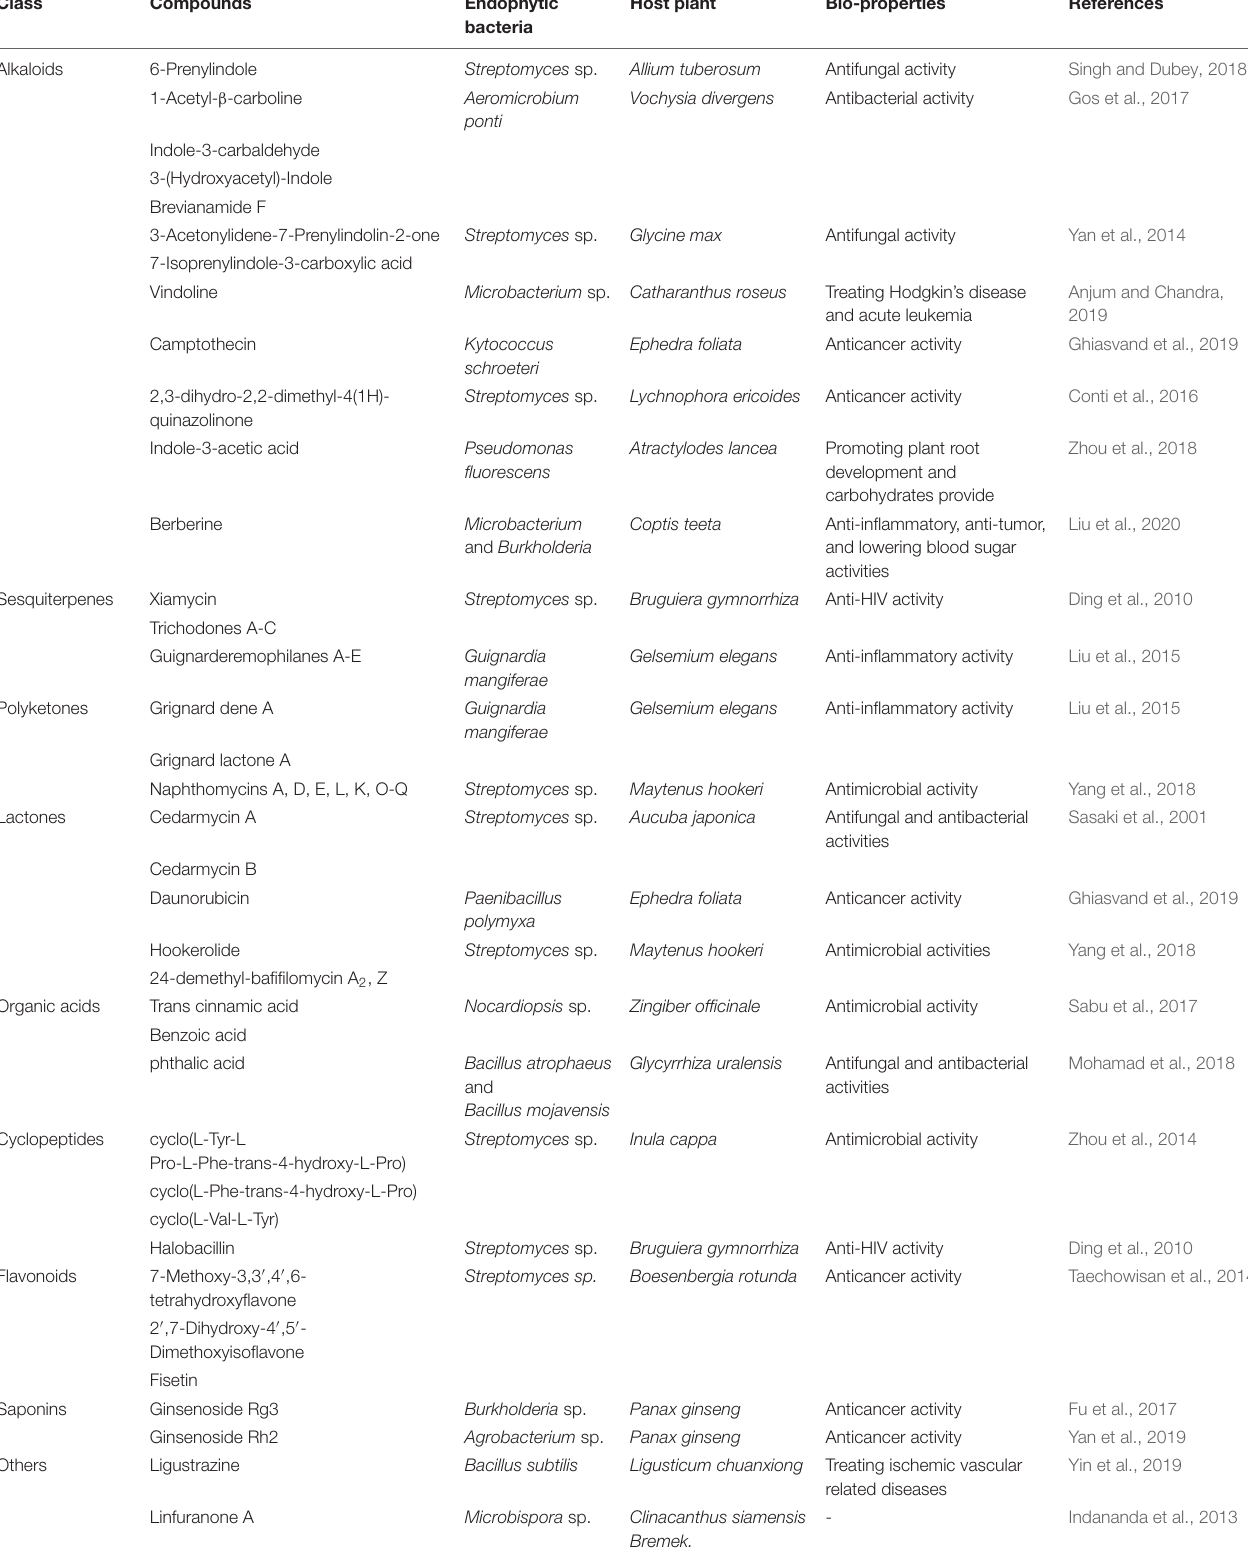
TABLE 3 | Secondary metabolites originated from endophytic bacteria in medicinal plants and their